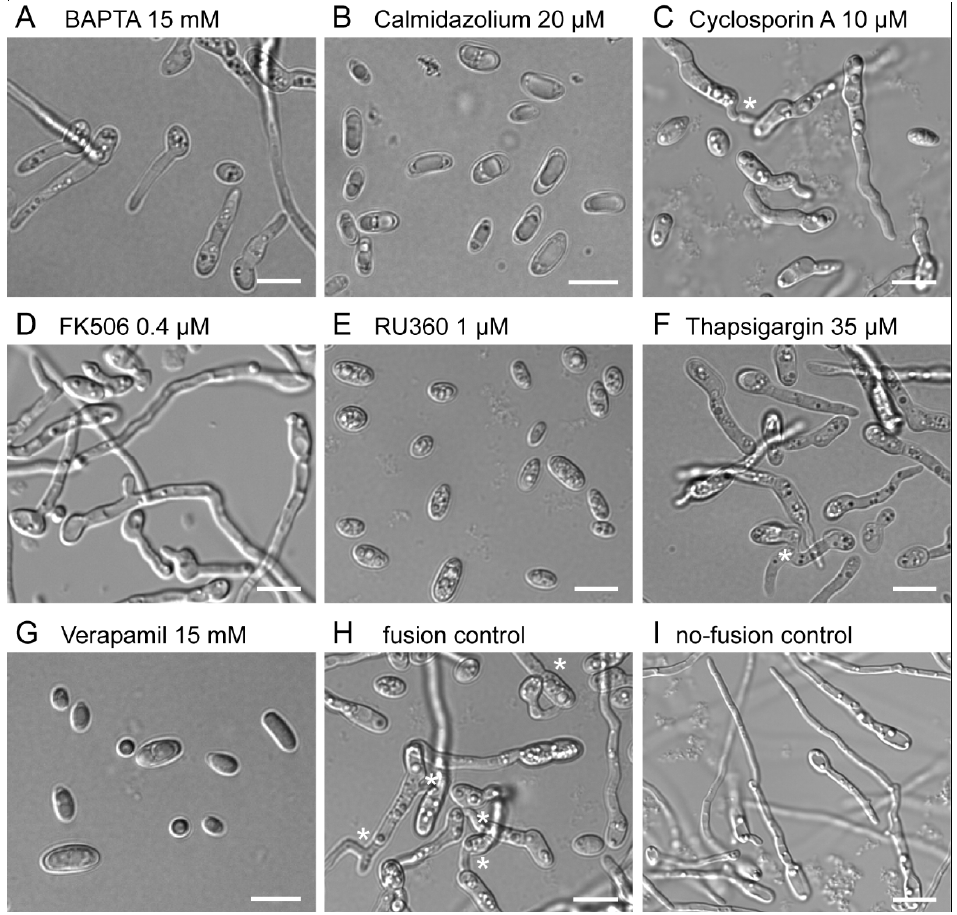
Figure 1. Effect of calcium-signalling inhibitors on germination and CAT-mediated cell fusion. ( A ) Chelation of extracellular Ca 2+ with BAPTA inhibits the formation of CATs and thus blocks cell fusion very effectively. Germ-tube formation and elongation are unaffected. ( B ) Calmidazolium, which also blocks calmodulin/calcineurin signalling, already affects germination, germ-tube elongation and CAT-mediated cell fusion at low concentrations. Nevertheless, CAT formation is much more sensitive compared to germ-tube formation. ( C ) Cyclosporin A, on the other hand, which also acts on calcineurin signalling, has a stronger inhibitory effect on CAT-mediated cell fusion. ( D ) Inactivation of calcineurin signalling with FK506 has a strong inhibitory effect on CAT formation but not on germ-tube development. ( E ) Inhibition of mitochondrial calcium uniporters with RU360 results in a very similar phenotype compared to verapamil, though at much lower effective concentrations. ( F ) Inhibition of Ca 2+ influx into the ER with thapsigargin has only a weak but specific effect on CAT formation. ( G ) Inactivation of Ca 2+ plasma-membrane channels with verapamil supresses germination altogether. ( H ) In the positive control (1% PDB + NaNO 3 fusion medium), germination, germ-tube elongation and germling fusion (*) occur with high frequencies, whereas ( I ) in the absence of NaNO 3 (1% PDB only), CAT formation (and hence germling fusion) cannot take place, and only elongated germ tubes are produced. Scale bars, 10 µm.